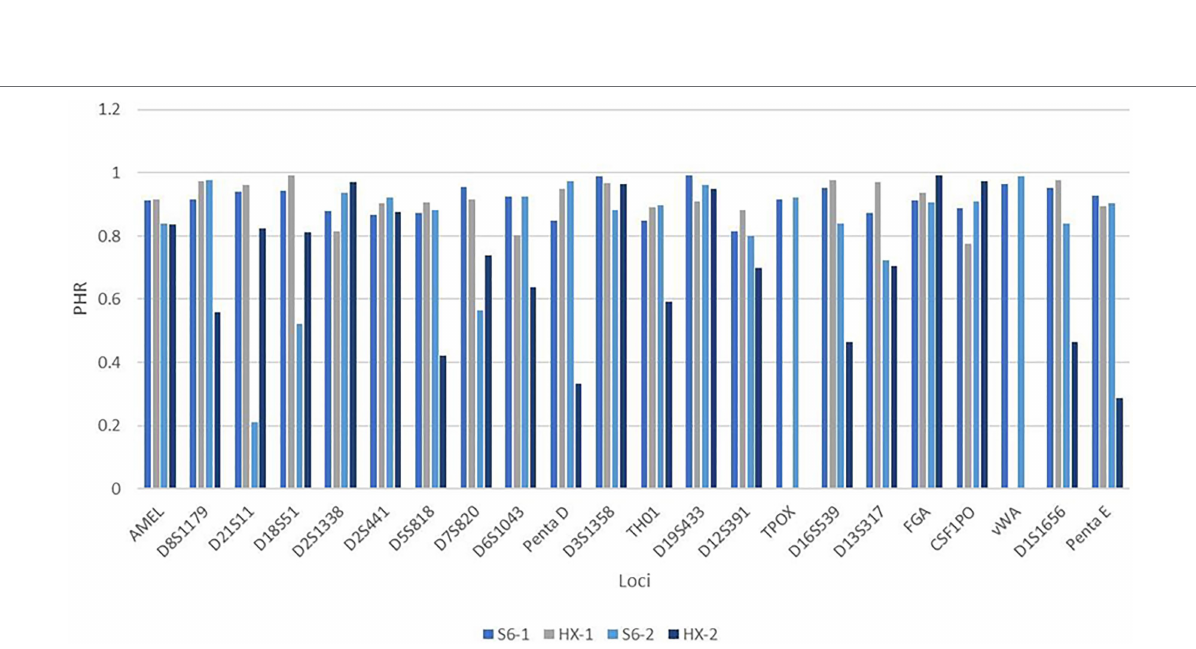
FIGURE 5 | The bar plot showed the PHR values of sample 1 and sample 2 when tested by HX kit and S6 system. The y -axis was the PHR value and the x -axis was the locus. For figure legends listed on the bottom of the plot, S6-1 represented that sample 1 was amplified with S6; HX-1 represented that sample 1 was amplified with HX; S6-2 represented that sample 2 was amplified with S6; and HX-2 represented that sample 2 was amplified with HX. The height of each bar represented the PHR value of each